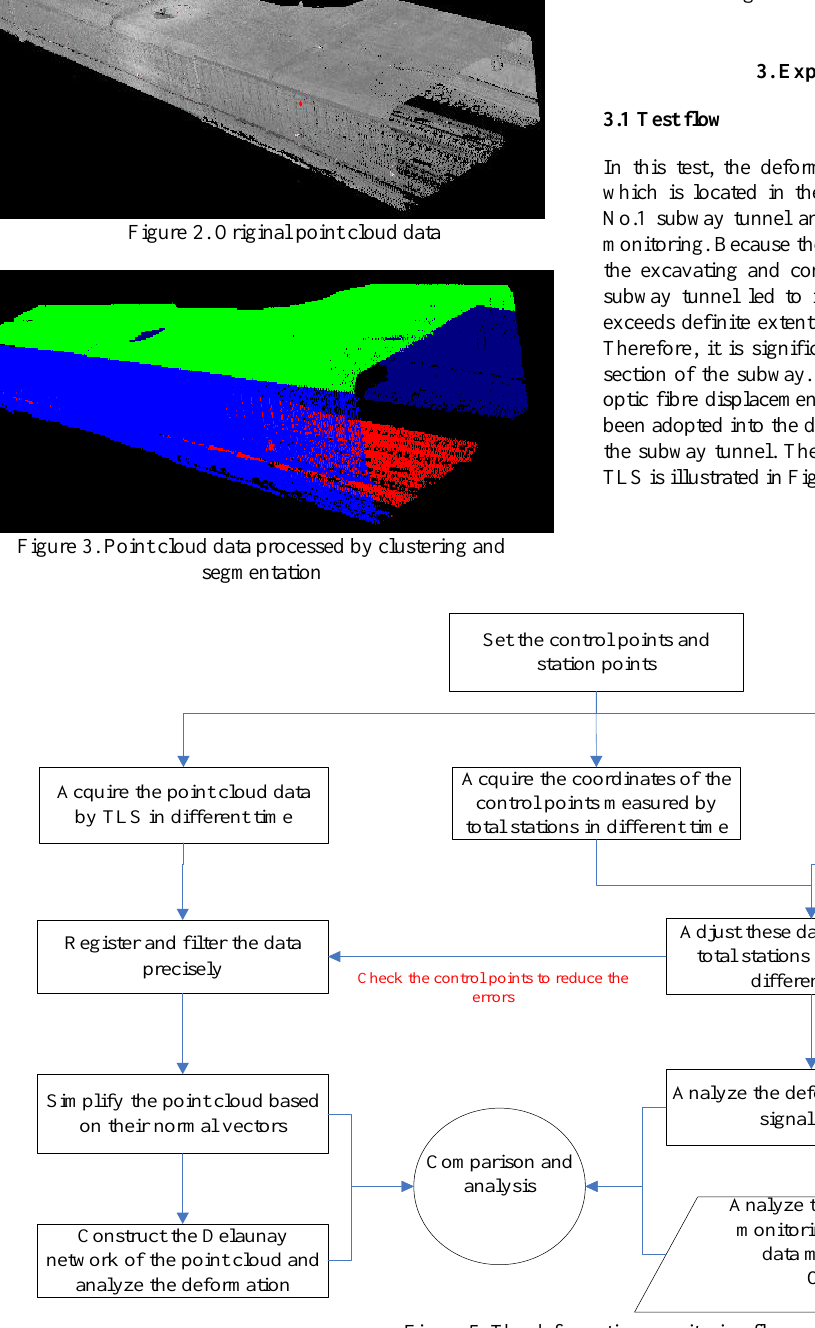
Figure 5. The deformation monitoring